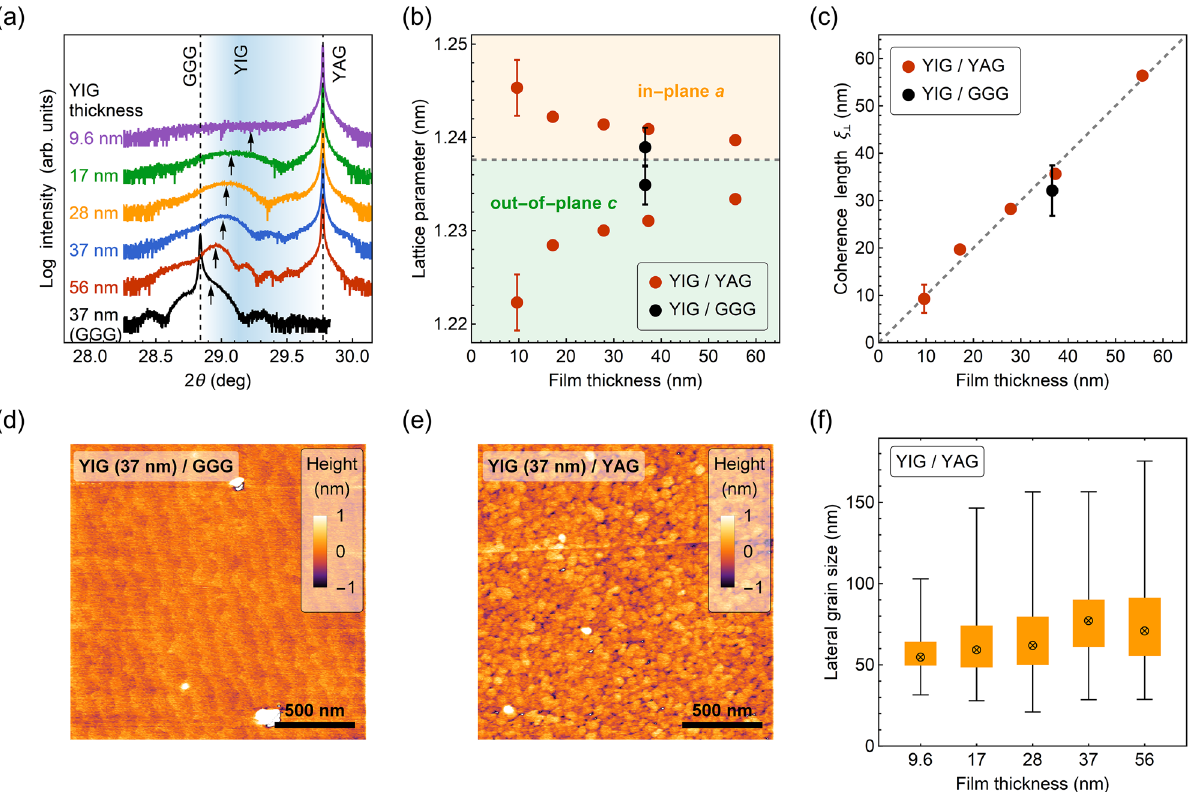
Figure 1. ( a ) X-ray ω-2θ diffraction patterns. (004) reflections of YIG are marked with arrows. The sharp peaks at 29.77° correspond to YAG (004) reflection, while the peak at 28.84° corresponds to GGG (004) reflection. ( b ) Thickness dependence of the determined out-of-plane lattice parameters c and calculated in-plane lattice parameters a . The dashed line corresponds to the value of a bulk, cubic YIG. Error bars represent one standard deviation uncertainty. ( c ) Thickness dependence of the x-ray coherence length determined via Scherrer equation. The dashed line serves as a guide to the eye showing a one-to-one correlation of the values. ( d ) and ( e ) display surface morphologies of YIG films grown on YAG and GGG substrate. ( f ) Box-whisker plot of the grain size distributions. For each film thickness, the statistics are based on at least 300 grain measurements. The ⊗ marker corresponds to the median value, the bottom and the top box edges to 25th and 75th percentile, respectively, and the black lines to the upper and lower fence, illustrating extreme values in the tails of the